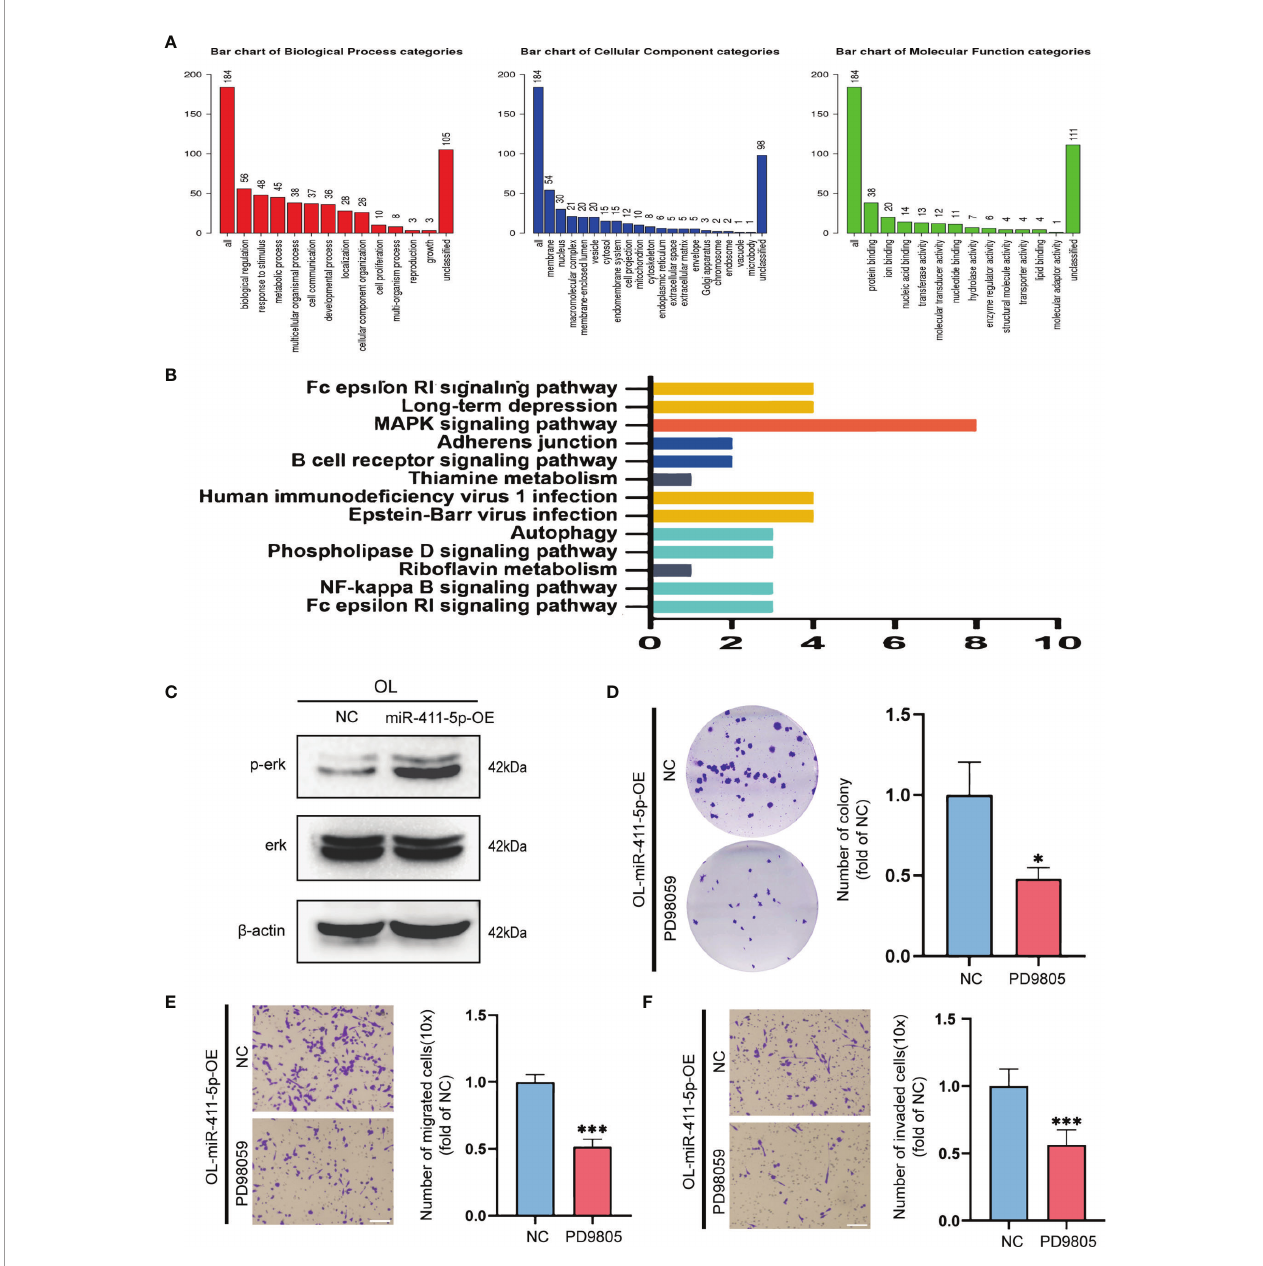
FIGURE 5 | The pro-metastatic activity of miR-411-5p was achieved by activation of the MAPK/ERK signaling pathway. (A) GO analysis of the target genes of miR-411- 5p. (B) KEGG pathway analysis of the target genes of miR-411-5p. (C) The protein level of p-Erk and Erk in OL-NC and OL-miR-411-5p mimic. The effect of ERK1/2 inhibitor PD98059 (20 m mol/L) treatment on the colony formation of OL-miR-411-5p-OE cells was measured using colony formation assays (D) , *p<0.05). Transwell assays without Matrigel or with Matrigel were used to determine the effect of ERK1/2 inhibitor PD98059 (20 m mol/L) treatment on the migration (E) , bar = 60 m m, ***p<0.001) and invasion (F) , bar = 60 m m, ***p<0.001) of OL-miR-411-5p-OE cells,